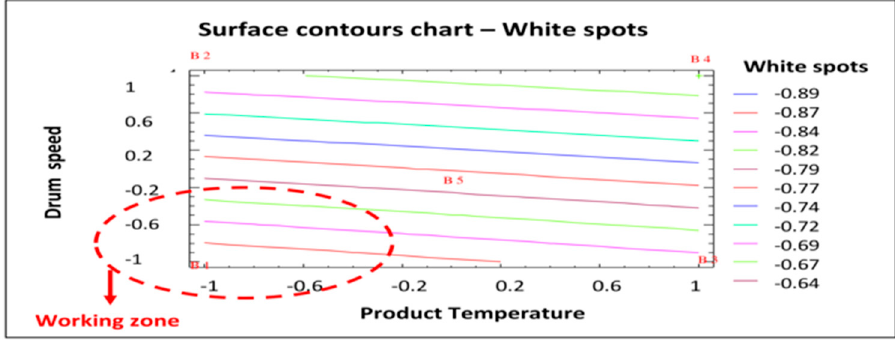
Figure 7. Surface contours chart—White spots. B1: Show the conditions assayed of Batch 1, etc.